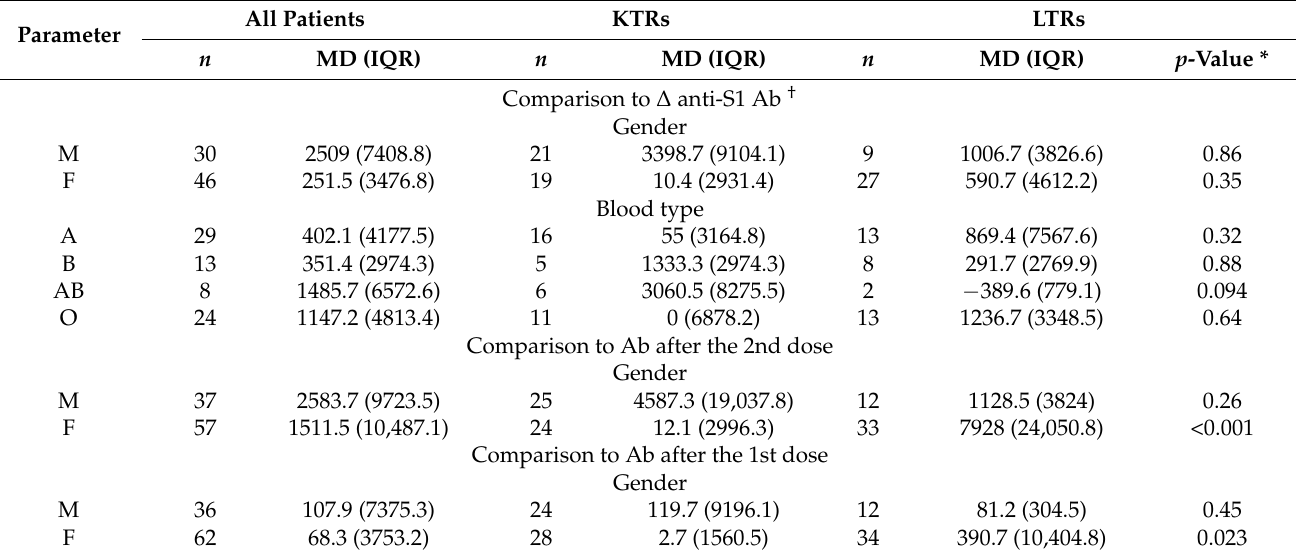
Table 4. Comparison of SARS-CoV-2 spike protein Ab concentration (AU/mL) after BNT162b2 vaccination with clini- cal